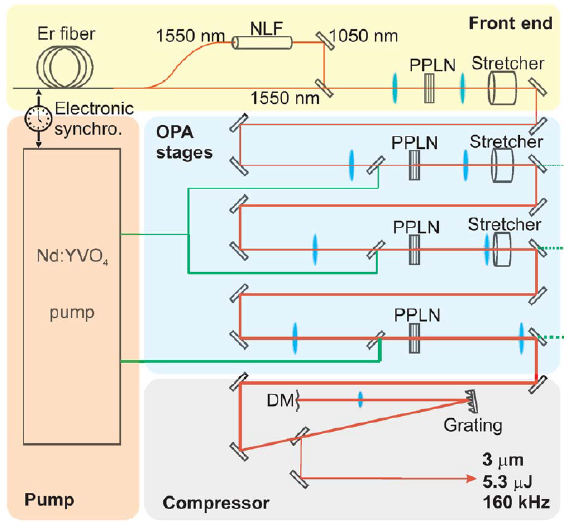
Figure 8. Scheme of the OPCPA system. NLF, Non-Linear Fiber; DM, Deformable Mirror; PPLN, Periodically Poled Lithium Niobate crystal. Adapted with permission from [50], Copyright OSA Publishing,